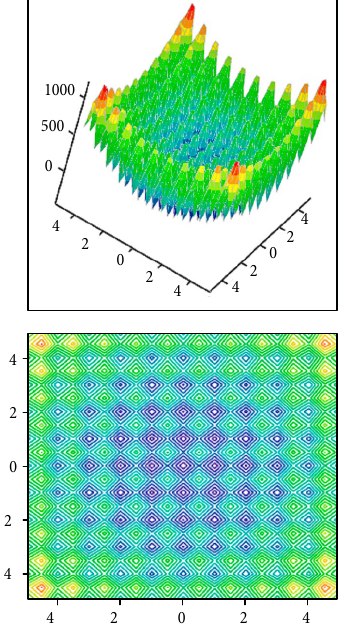
Fig. 2. Rastrigin function with 2 vari- ables and its contour